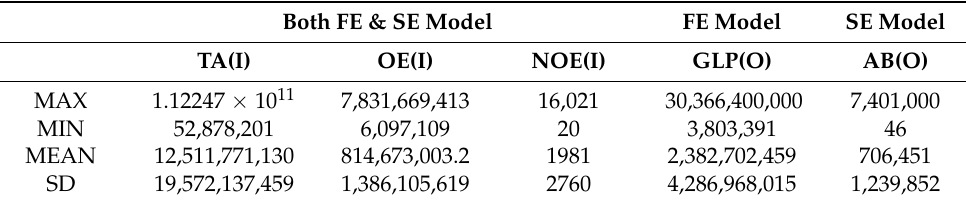
Table 3. Descriptive statistics of inputs and outputs for the years 2015–2019 for financial efficiency and social efficiency